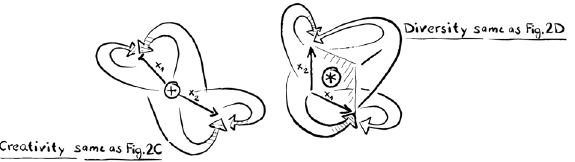
Fig. 9 Models of creativity and diversi fi cation visualized in a graphical language inspired from geometry. The causal models that we have developed in this article can be visualized in a graphical language inspired from geometry. The model of creativity then becomes a model in which creative steps are lines that add up to stretch further and further out into the unknown left . By contrast, the model used to study diversi fi cation becomes a model in which opposite forces act like axes that span planes and spaces right . In mathematical terms, the two models shown here are the same as those of Fig. 2C and D. Each graphical style has its merit. The present lines-planes representation is better at illustrating mathematical aspects, while the previous causal Venn diagram better illustrates aspects of logic. The workings of the model on the right are also explained in my video available online at https://doi.org/10.25496/W2QP46.